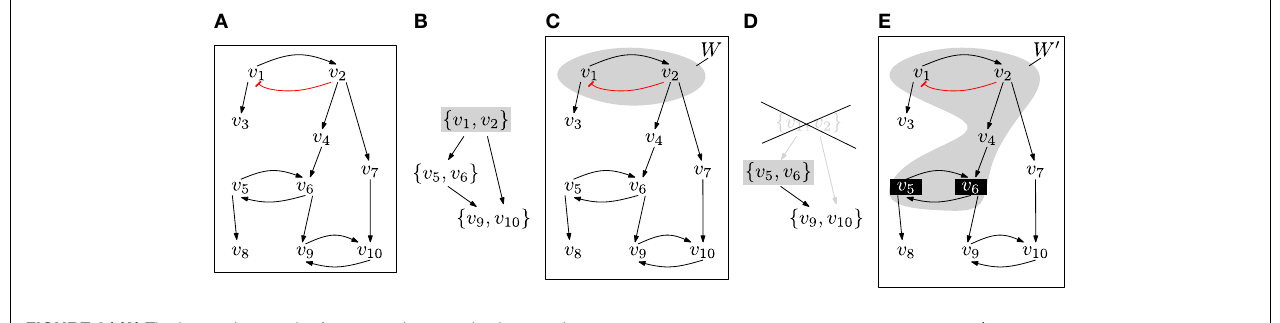
FIGURE 2 | (A) The interaction graph of an example network where each f i is the disjunction of its inputs (e.g., f 6 = v 5 + v 4 ) except for v 1 which is inhibited by v 2 ( f 1 := v 2 ). (B) The condensation graph ( Z , ◃ ) with the unique top layer node { v 1 v 2 }. (C) The corresponding minimal autonomous set W . The restriction ( W , F | W ) is trap-space-free.